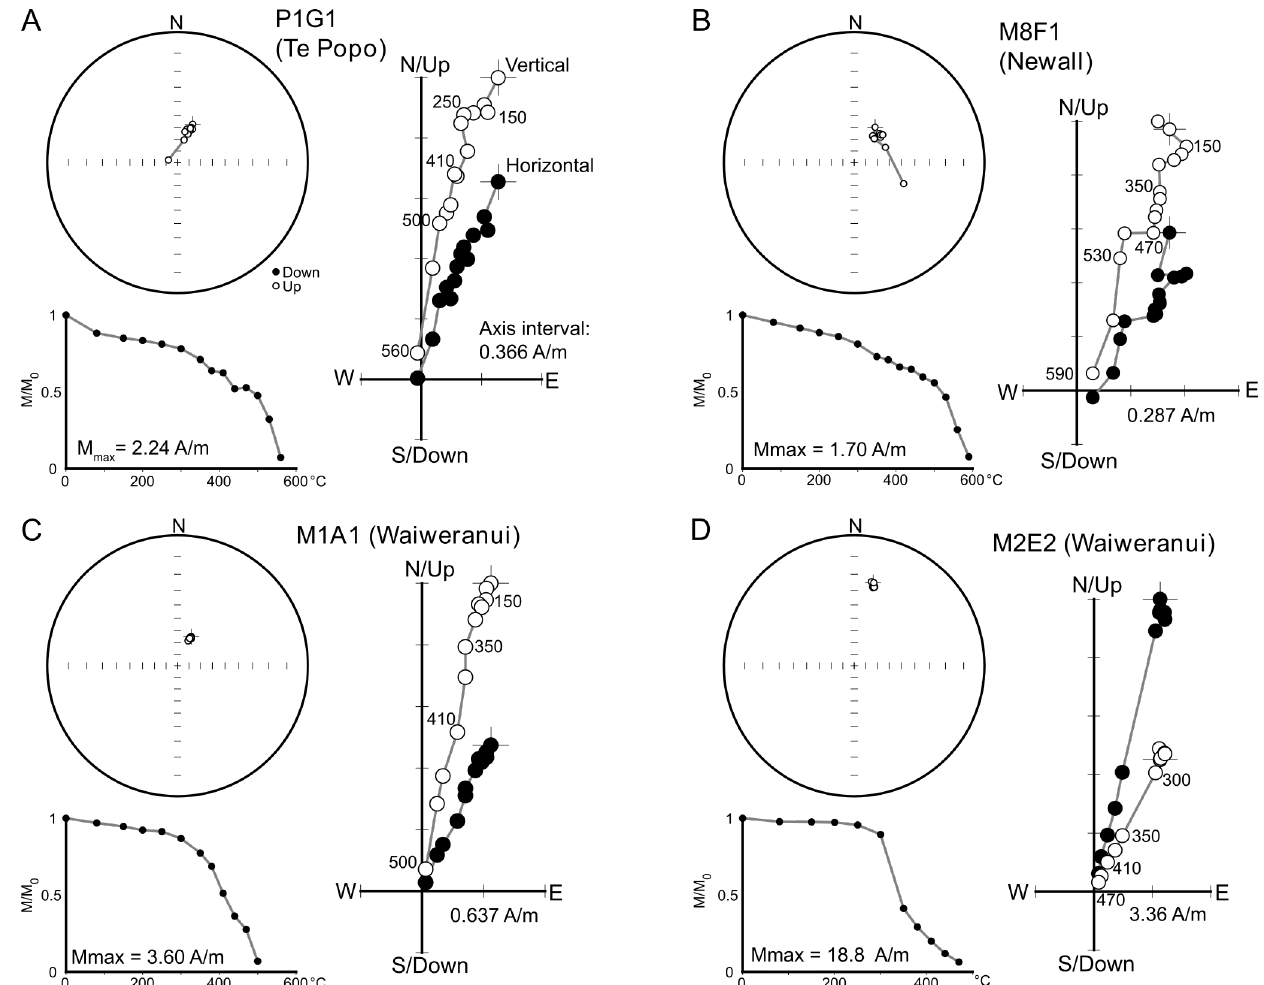
Figure 5: Progressive thermal demagnetization data for specimens from Maero deposits. [A] to [G] represent samples from sites of decreasing age within the sequence (unit name specified for each specimen). Diagrams show decrease of normalised remanent intensity with demagnetization ( M/M 0 = magnetization at demagnetization step/initial magnetization), equal angle plot of remanent direction (open circles represent projections on the upper hemisphere, closed circles represent projections on the lower hemisphere), and vector component plot showing horizontal and vertical components of remanence (solid and open dots, respectively; number labels represent thermal demagnetization temperature steps in ◦ C). [Continued on next